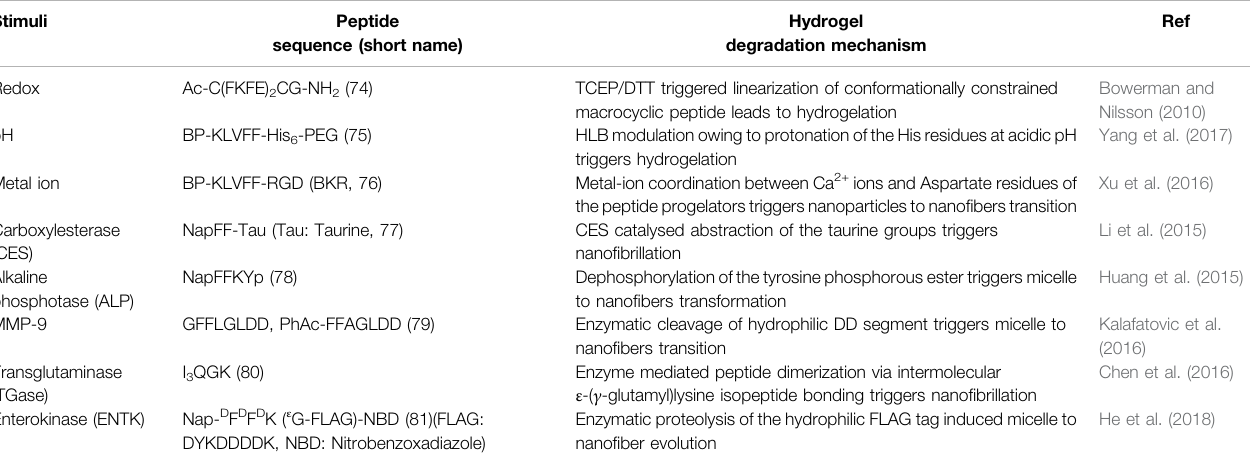
TABLE 2 | Examples of bio-sensitized peptide